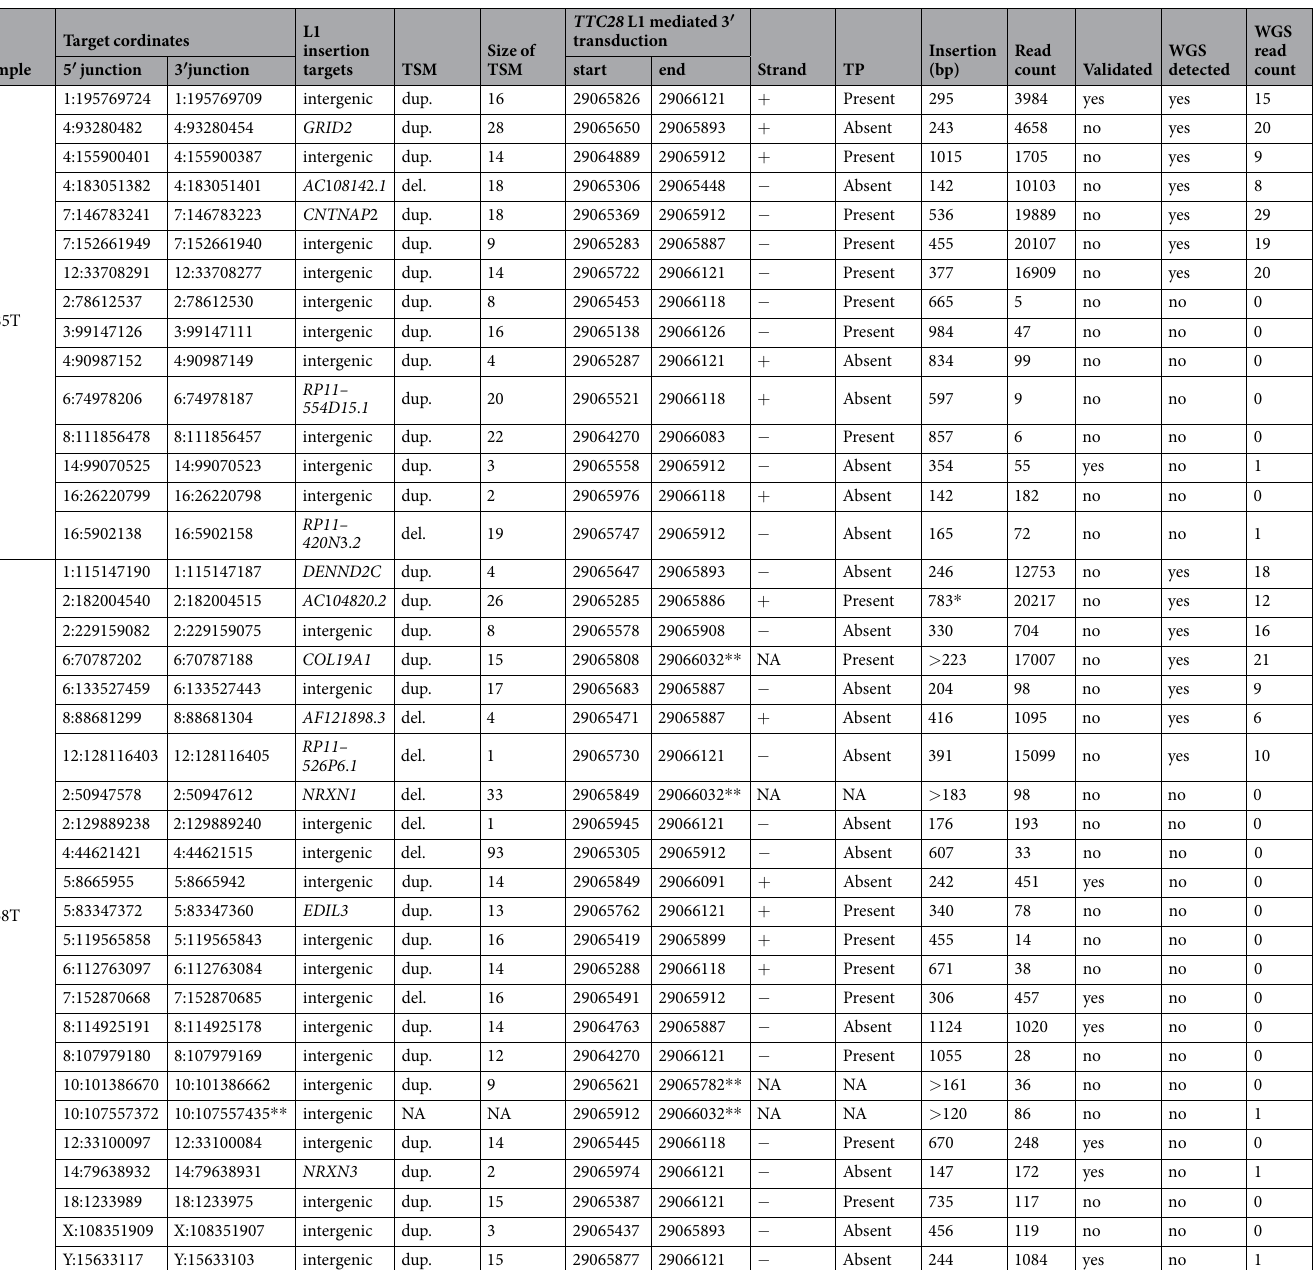
Table 1. Insertions detected by LDI-PCR/Nanopore sequencing. Note that one insertion was predicted by WGS but not by LDI-PCR/Nanopore and not included in the table. TSM = target-site modification; TP = twin- priming; del. = deletion; dup. = duplication; Read count = Number of LDI-PCR.py reads supporting each insertion, if one insertion was detected by more than one enzyme or primer pair, only the reaction with higher number of reads was included; * includes internal duplication; ** some sequence was